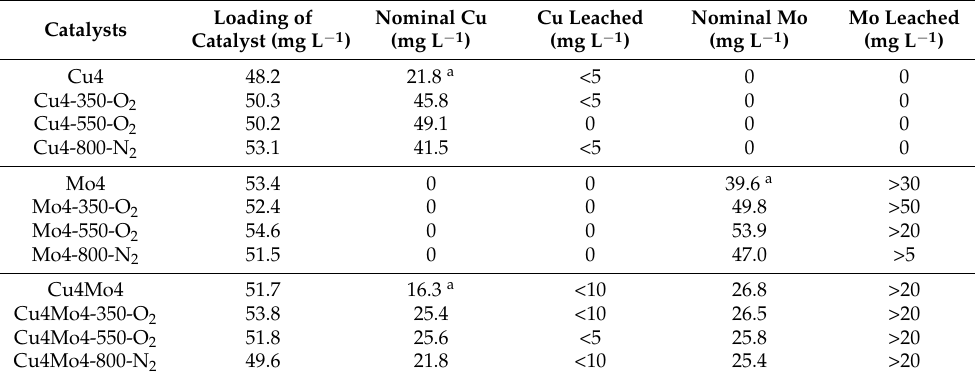
Table 6. Summary of the semiquantitative leaching analysis of Cu- and Mo-based catalysts.